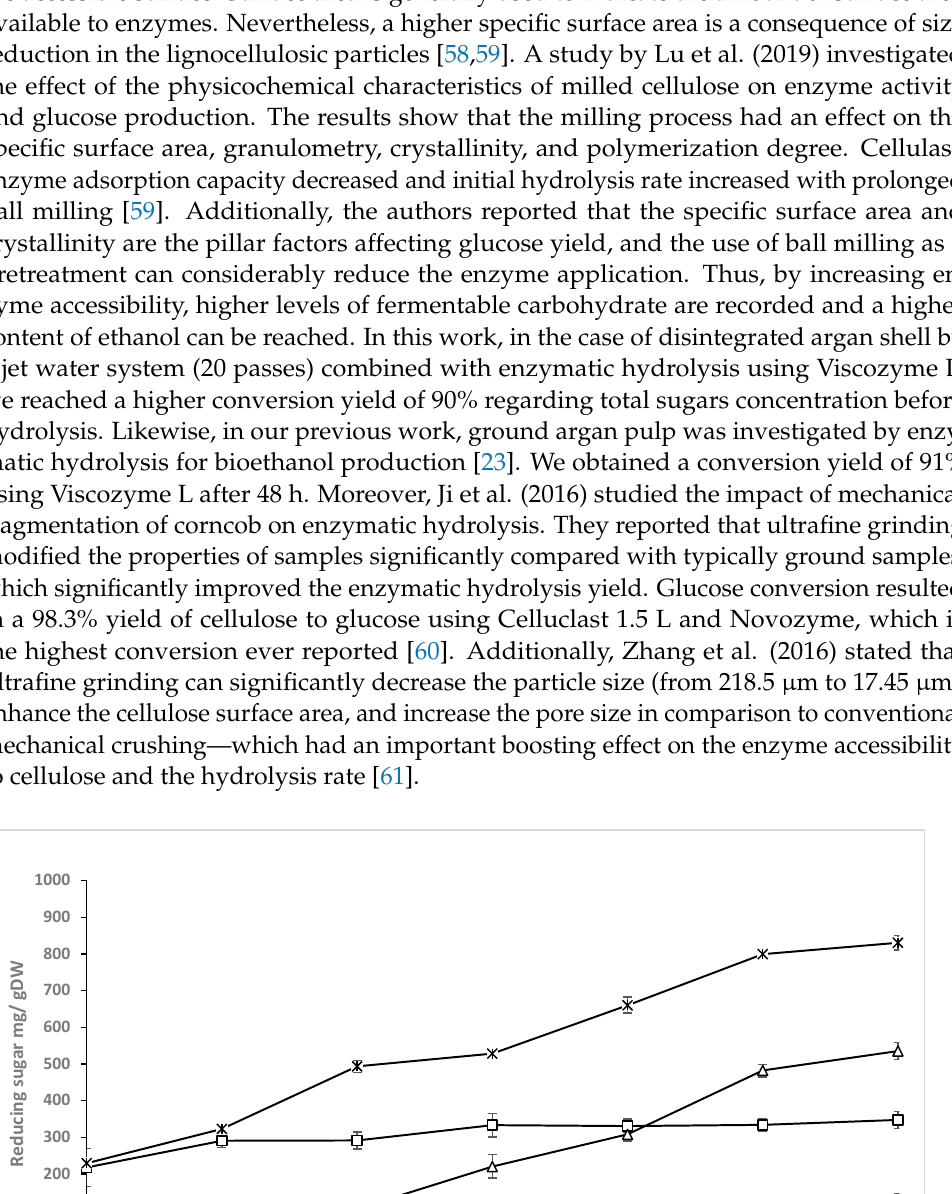
w / v using Viscozyme L (30